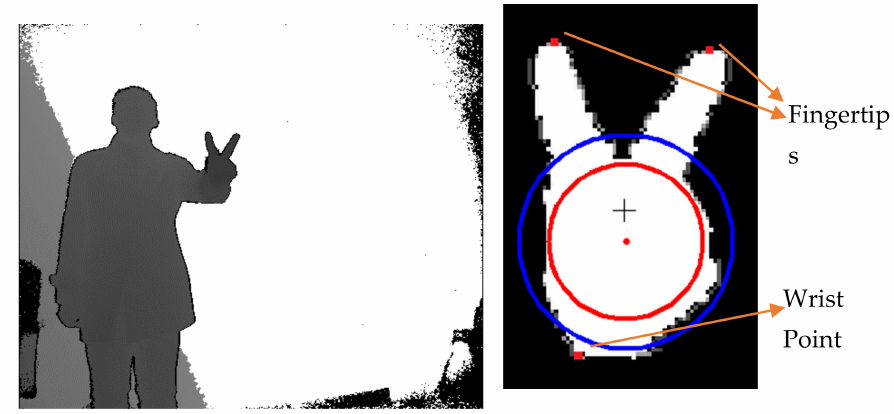
Figure 3. The depth image ( left ) and extracted elements ( right ): palm center with a higher quality denoted by RED point versus central moment of the hand by BLACK cross where the red and blue circles, respectively, represent inscribed and averaging